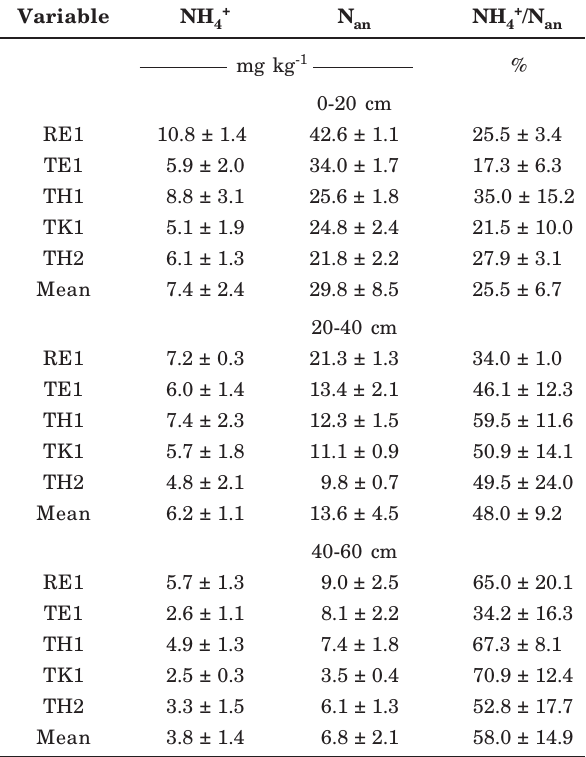
Table 3. Pre-existing NH 4+ -N in soil samples, mineralized N obtained by short-term anaerobic incubation (N an ) and the percentage ratio of pre- existing NH 4+ -N to mineralized N (NH 4+ /N an ) at three soil depths (mean ± standard